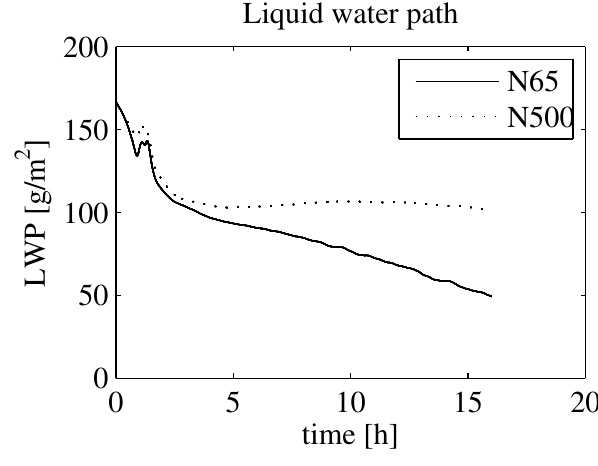
Fig. 4. Result for the moist heat bubble test case after 1000 s (contours: equiv. pot. temp. 0 . 5K)